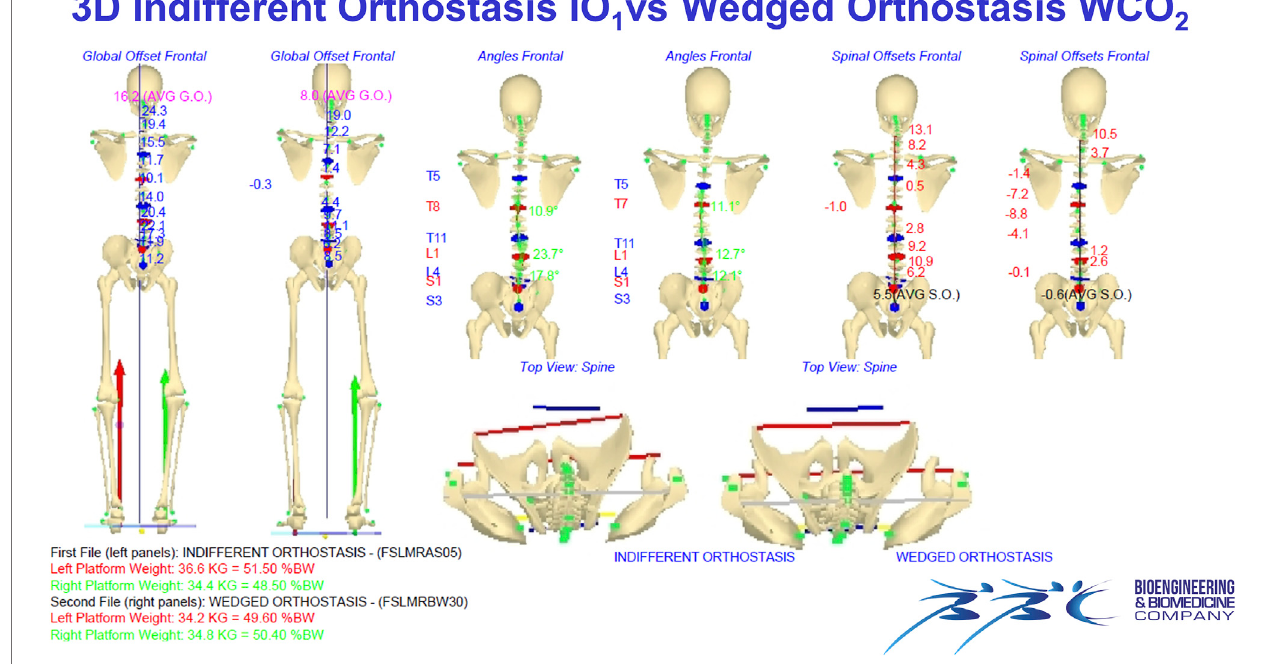
FIGURE2| ExampleofdataelaborationoutcomeandtherelatedgraphicalreportoftheIO 1 vs.WCO 2 measurementcomparisoninthefrontal(Panel2)andsagittal ( Figure 3 ) planes.